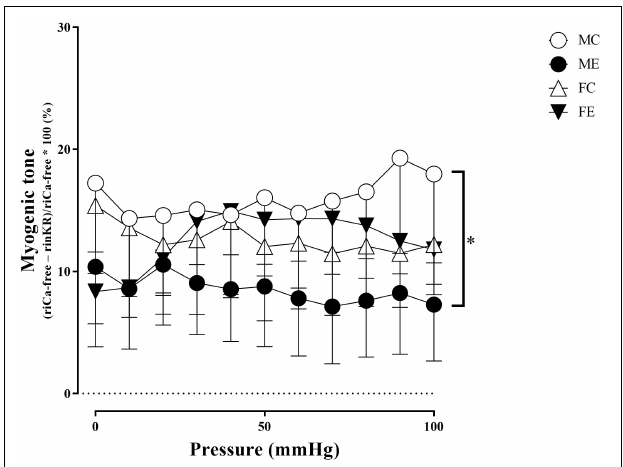
FIGURE 5 | Myogenic tone as a function of intraluminal pressure measured under passive conditions of the gracilis muscle arterioles from the MC, ME, FC, and FE animals. As a result of the exercise, the myogenic tone was significantly smaller in the ME rats than in the MC rats. The data are expressed as the mean (SEM) values. The significance levels of the two-way ANOVA and Tukey’s post hoc tests between the four groups are shown. ∗ P < 0.05 MC vs. ME.